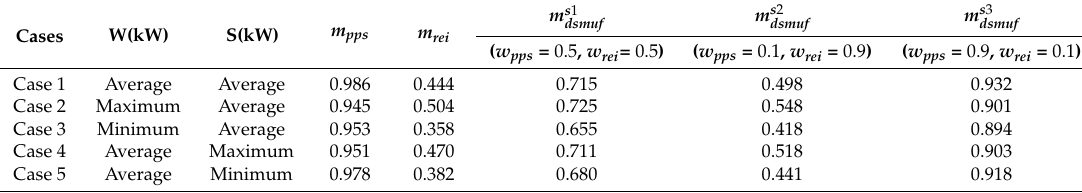
Table 4. OOUI for